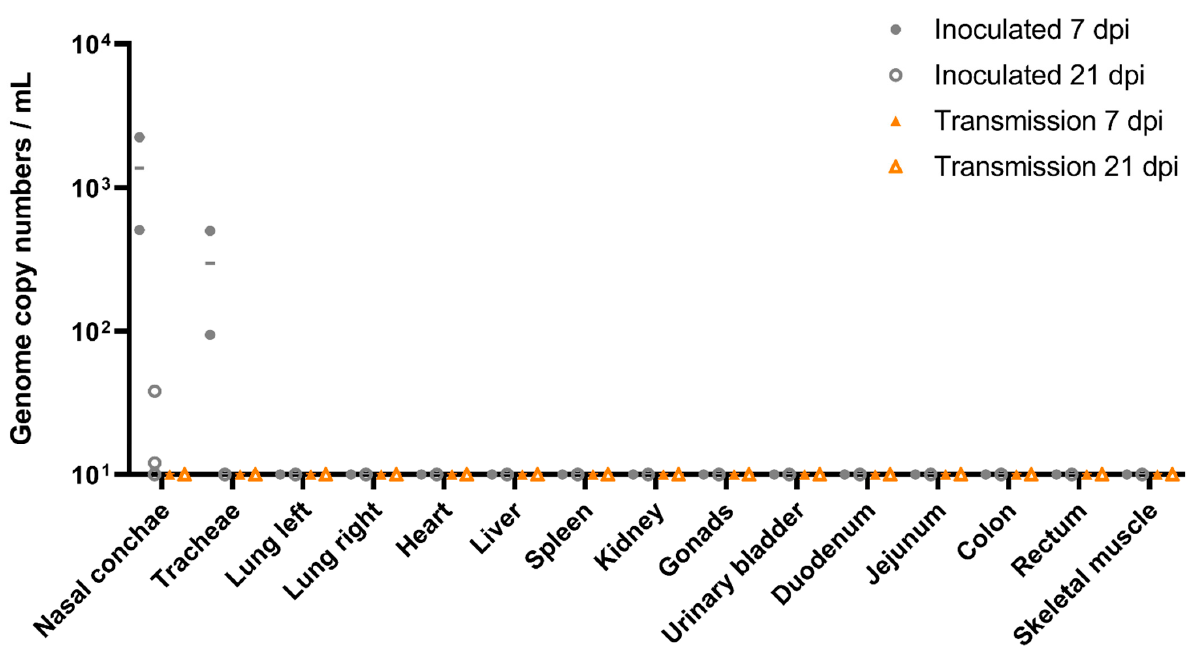
Figure 6. Viral loads in organs of A/bat/Egypt/381OP/2017 (H9N2)-inoculated Egyptian fruit bats. Individual results of detected viral RNA are depicted. Organs from two inoculated (filled grey dots) and two contact animals (filled orange triangles) were taken at 7 dpi, while organs from the residual four inoculated (open grey dots) and contact animals (open orange triangles) were taken after euthanasia at 21 dpi. Samples below 10 viral genome copy numbers per mL (equivalent to Ct 39.2) were considered negative.